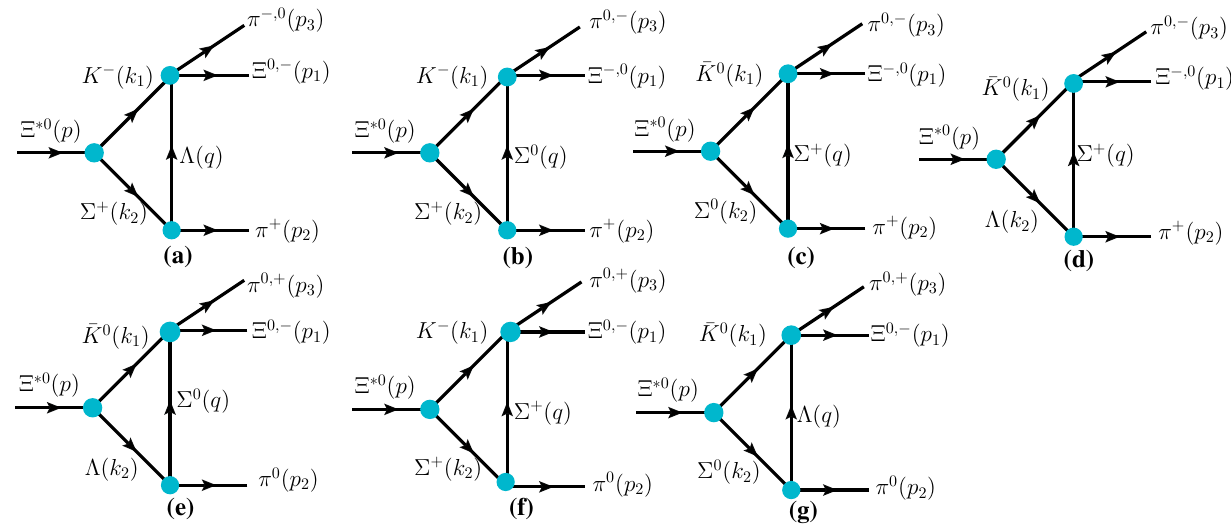
Fig. 3 Feynman diagrams for the Ξ ∗ 0 → π + Ξ − π 0 ,π 0 Ξ 0 π 0 and π + Ξ 0 π − decay processes. We also show the definitions of the kinematics ( p , k 1 , k 2 , p 1 , p 2 , p 3 , and q ) used in the calculation